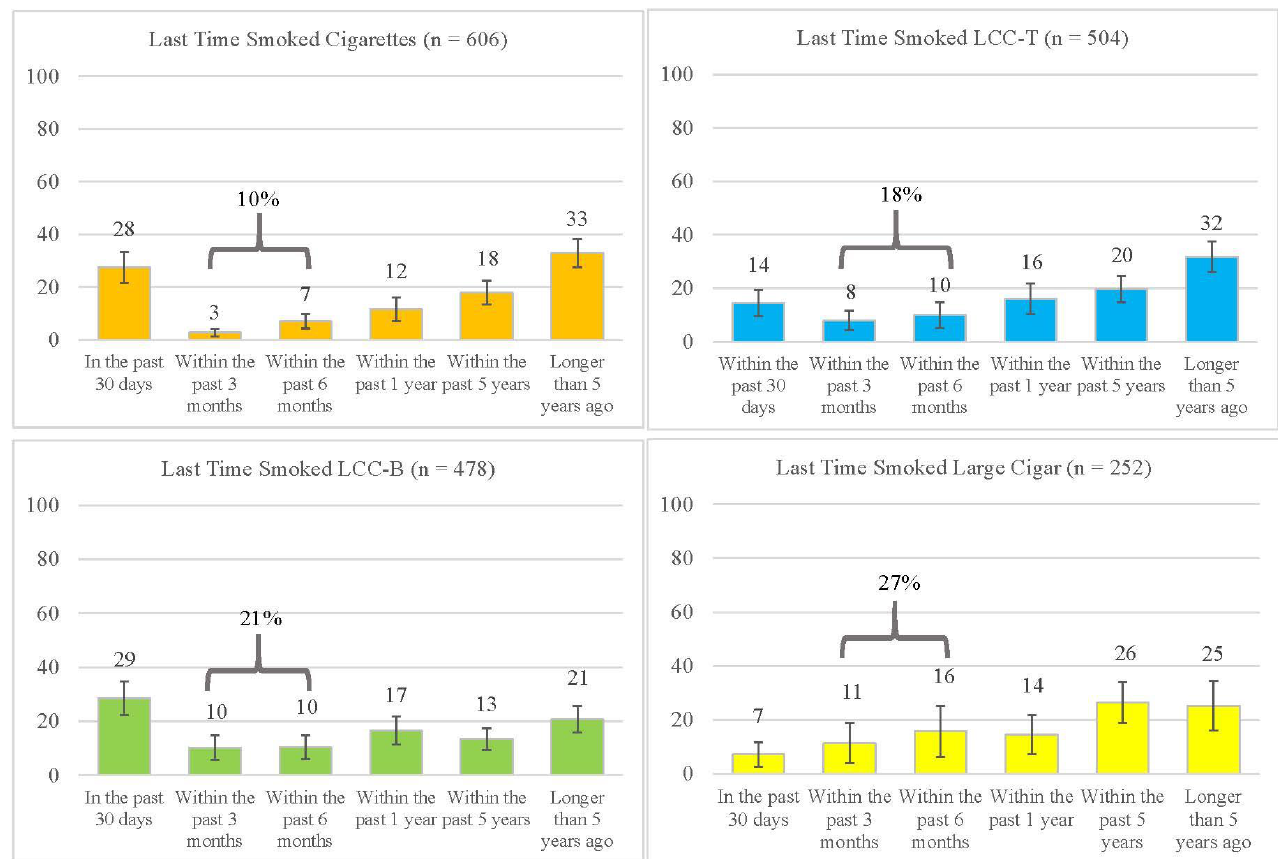
Figure 1. Time of Last Use of Cigarettes, LCC-Tobacco, LCC-Blunt, and Large Cigars among the C’RILLOS Sample ( n = 1063).